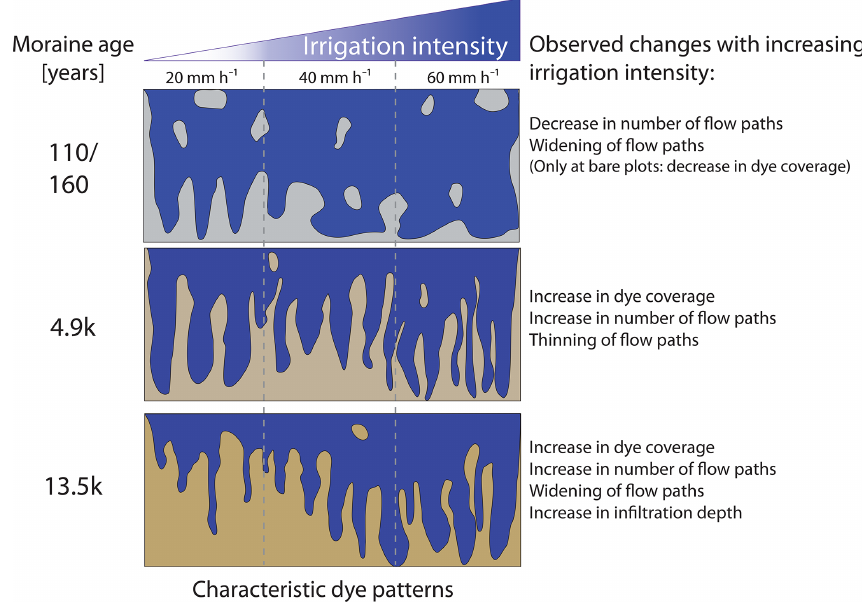
Figure 13. Characteristic dye patterns and observed changes with increasing irrigation intensity at the four age